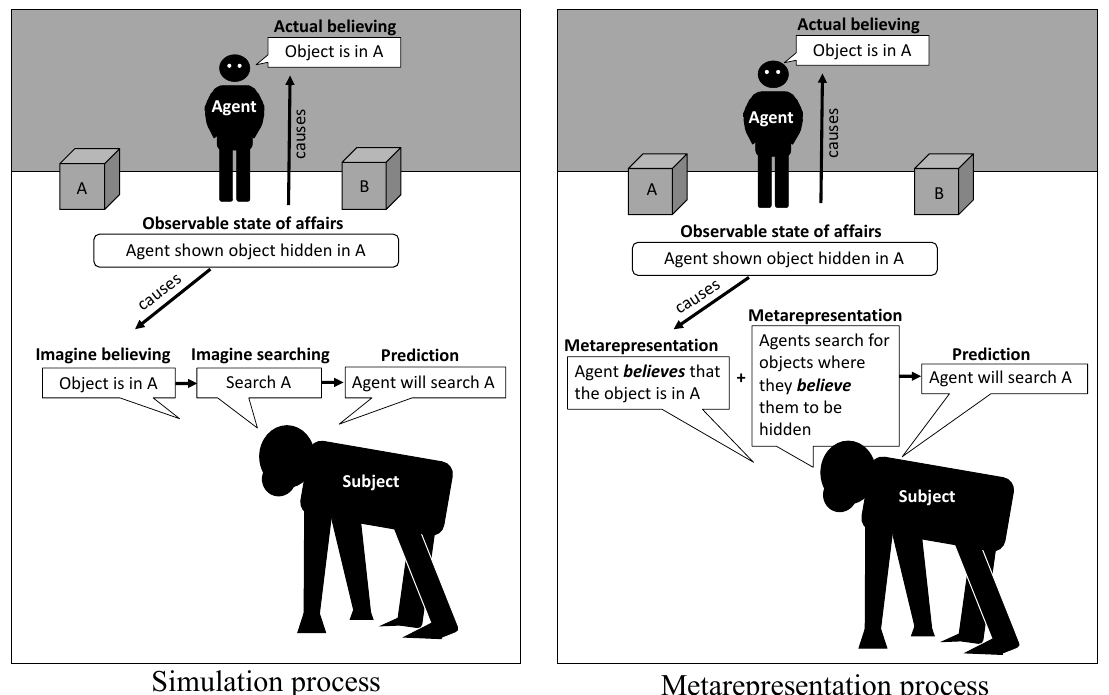
Simulation and Metarepresentation Explanations of the Krupenye et al. (2016)